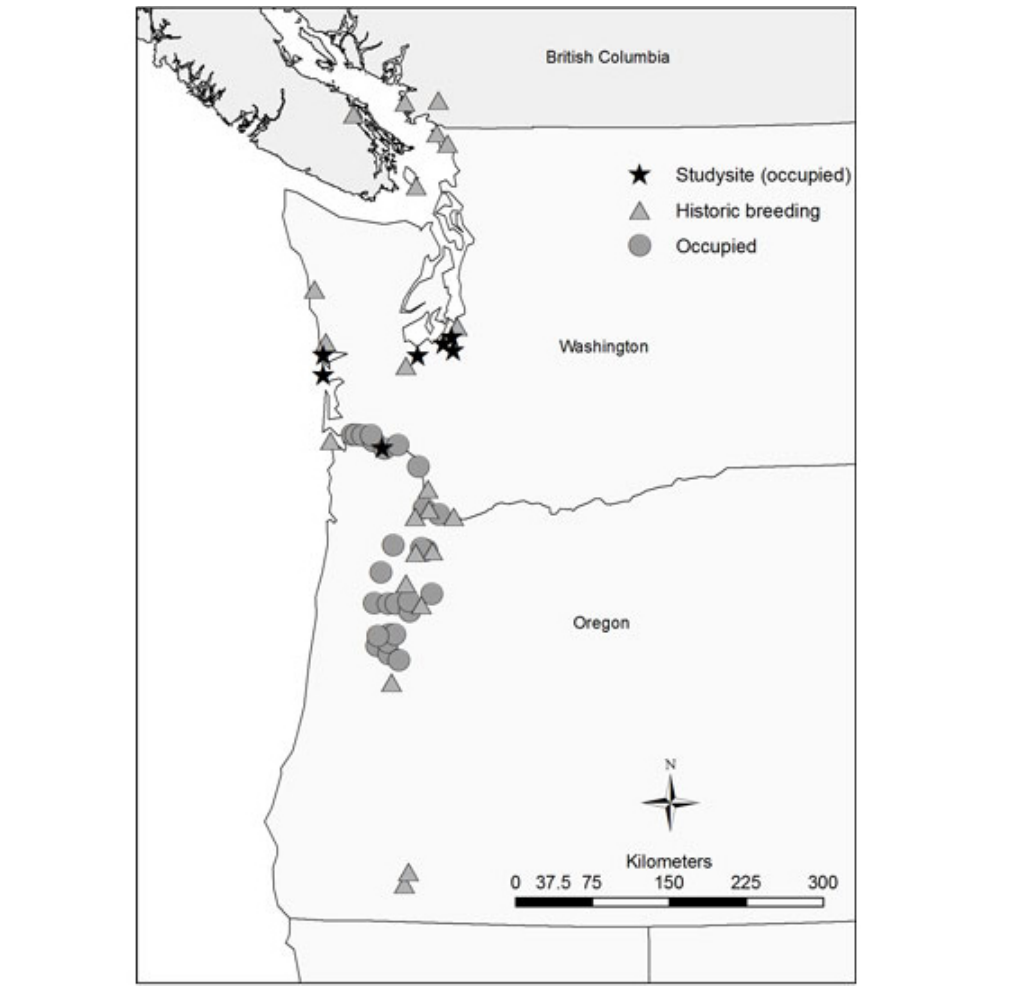
Fig. 1 . Map showing current and historic range of Streaked Horned Larks. Historic range has contracted in the north and south, leaving only the middle portion of the range occupied currently. Stars represent currently occupied sites that were included in the study; circles represent currently occupied sites that were not included in the study; and triangles represent known historic breeding